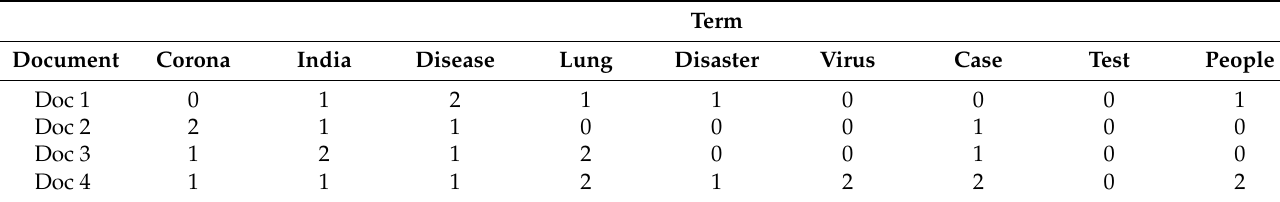
Table 2. Document Vector or Term-Frequency